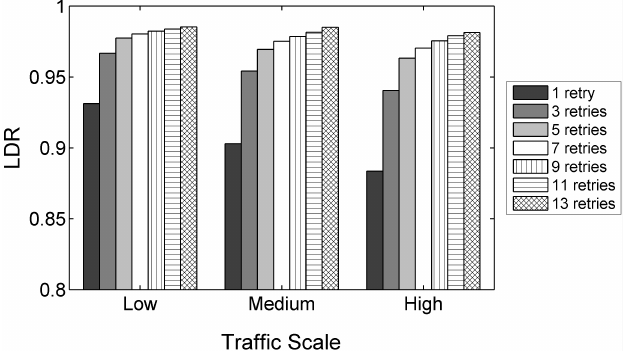
Figure 8. Link delivery ratio (LDR) for different values of macMaxFrameRetries in different traffic scenarios.